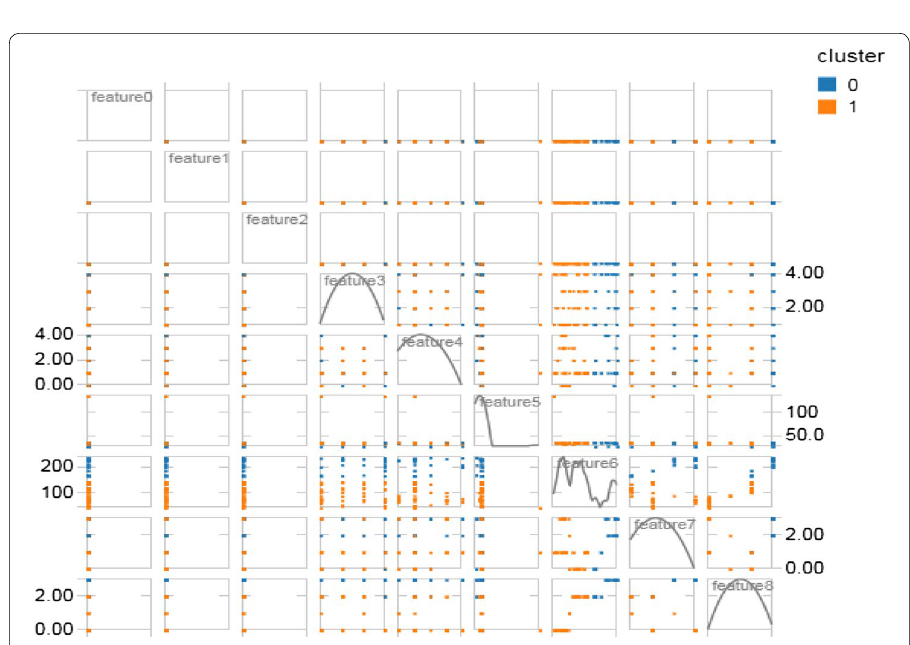
Fig. 11 Kmeans scatter